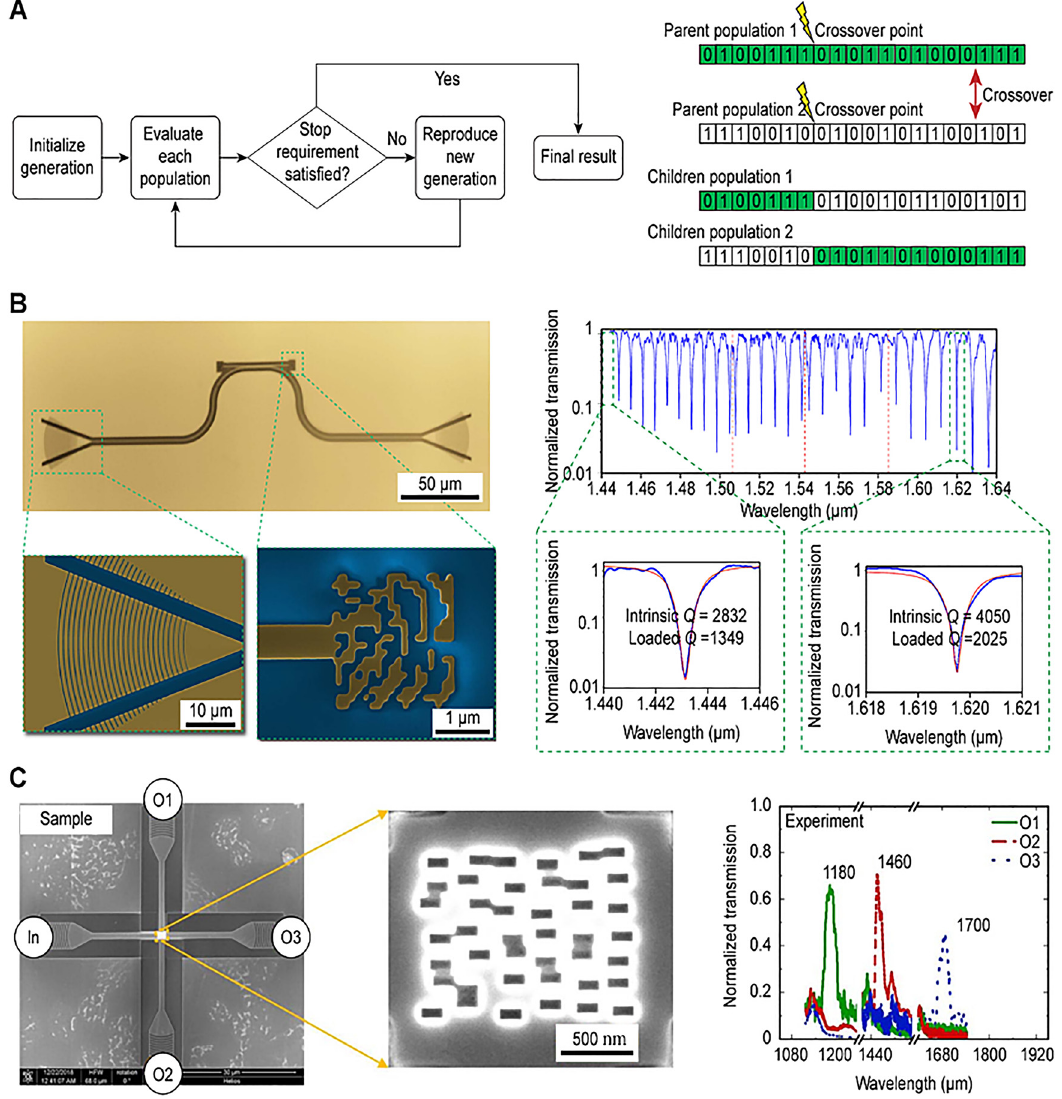
Figure 2: Illustration of the GA. (A) The flow chart of the optimization process. (B) On-chip wideband FP cavity. Left: optical microscope image of the FP cavity device and magnified scanning electron microscopy (SEM) image of the left grating coupler and the right reflector. Right: Normalized transmission spectrum of the FP cavity device and magnified spectra showing the optical resonances at 1443 and 1620 nm. Reproduced with permission [44]. Copyright 2017, Optical Society of America. (C) Three-channel wavelength router with a footprint of 1.8 × 1.4 µm. Left: SEM images of the fabricated device and a magni fi ed SEM image of the centre part of the device. Right: measured transmission spectrum. Reproduced with permission [47]. Copyright 2019, Optical Society of